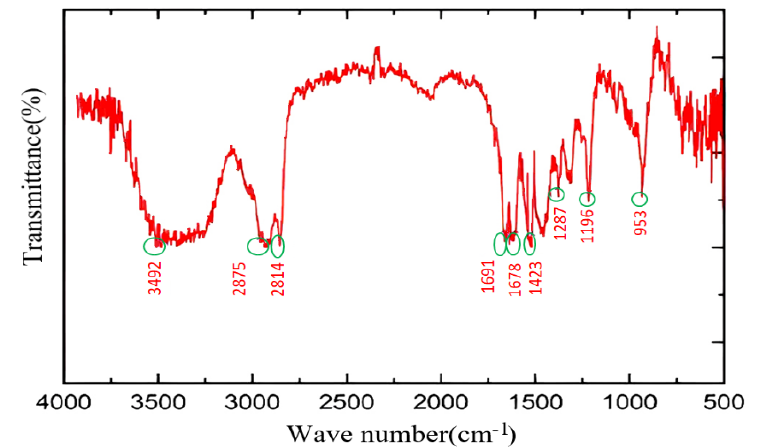
Figure 4. Fourier transform infrared (FTIR) spectral profiles recorded for CHM.